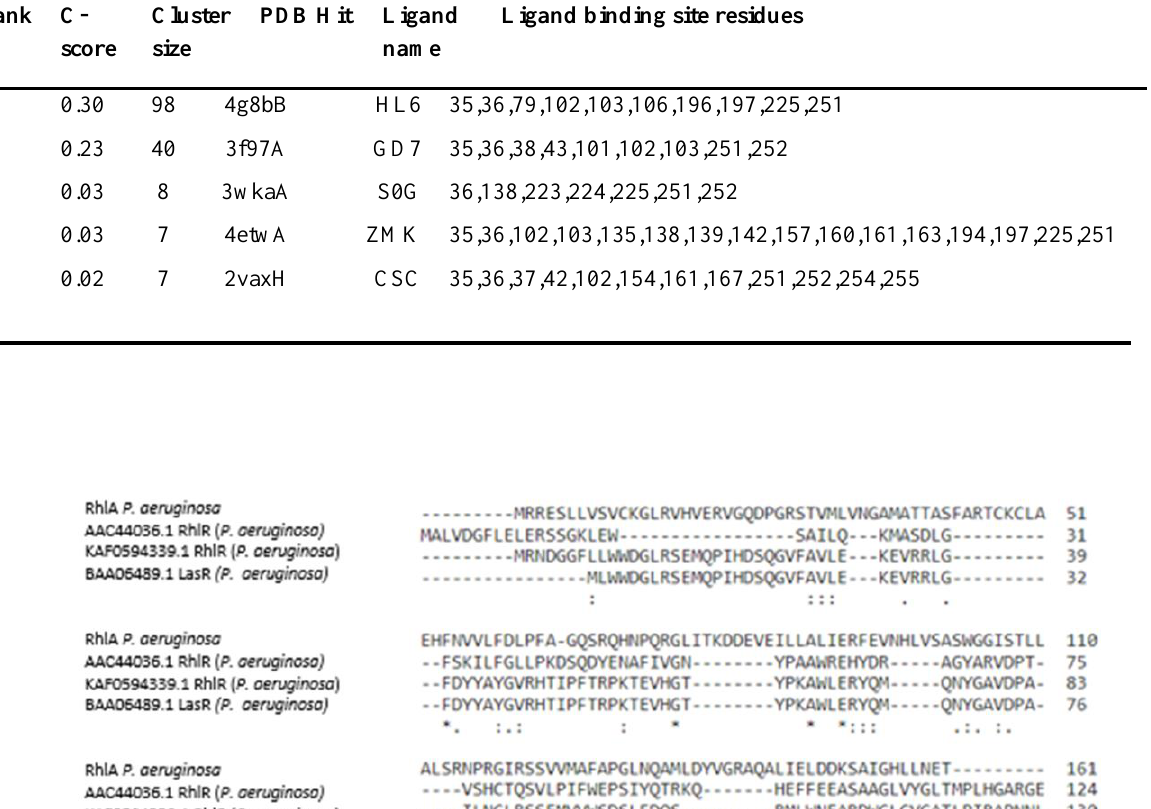
Table 1. The suggested ligand binding site residues according to I-Tasser